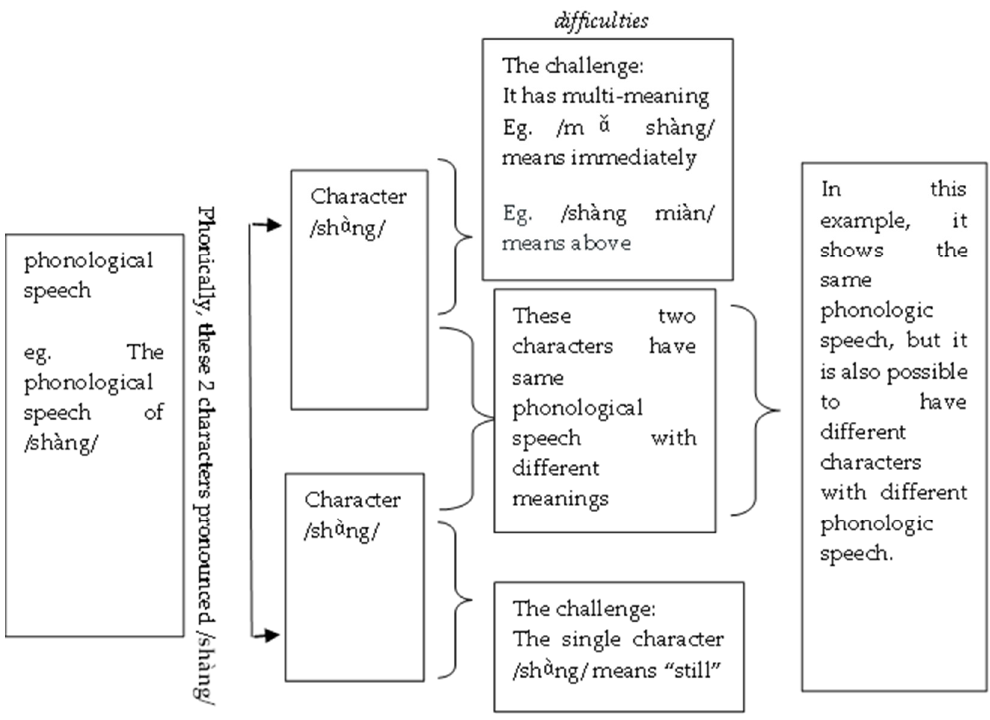
Figure 1. Complexity of Learning Chinese Language Characters: An Illustration.